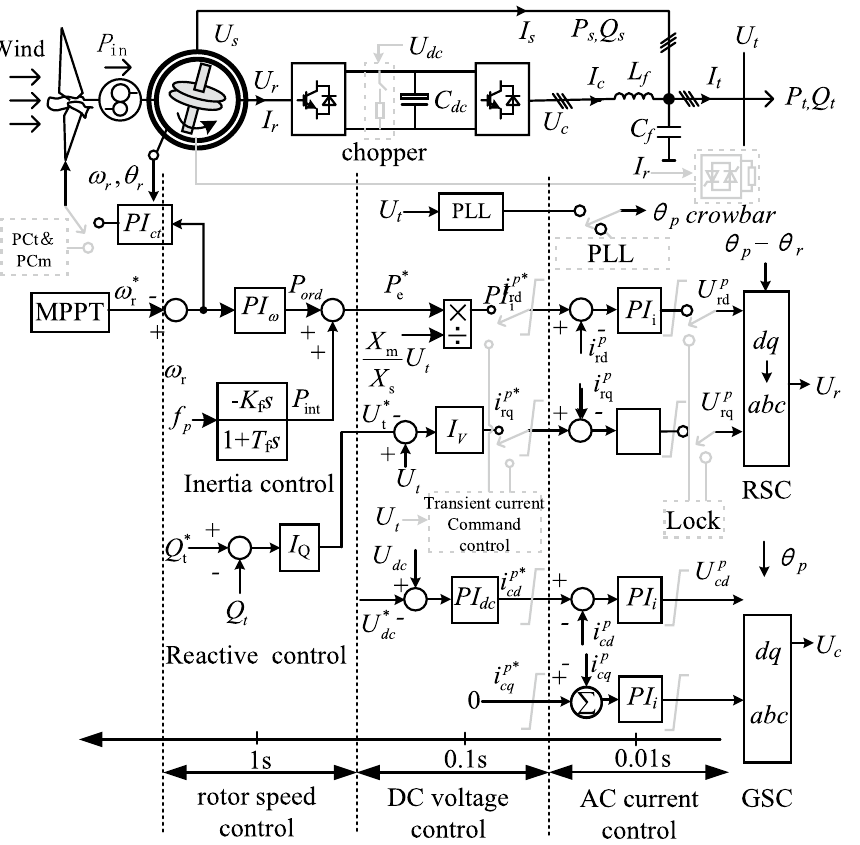
Figure 2. Typical control strategy and multi-scale division for doubly-fed wind